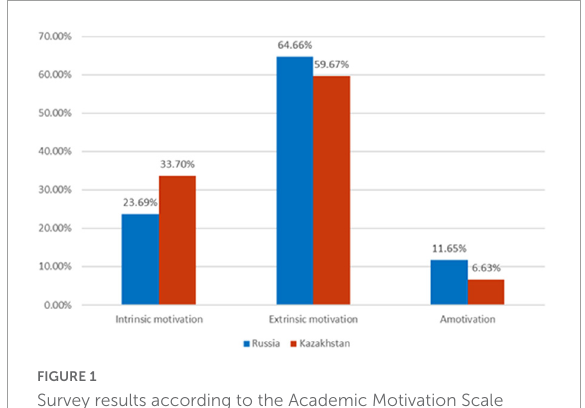
FIGURE1 Survey results according to the Academic Motivation Scale (in